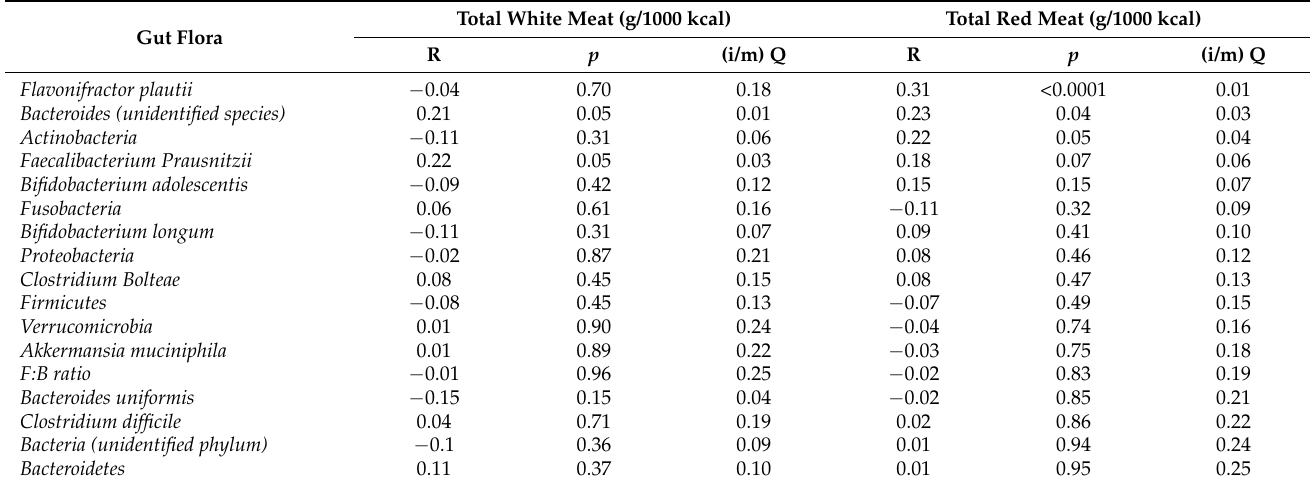
Table 2. Correlations between gut flora by type of meat intake among total participants 1 .